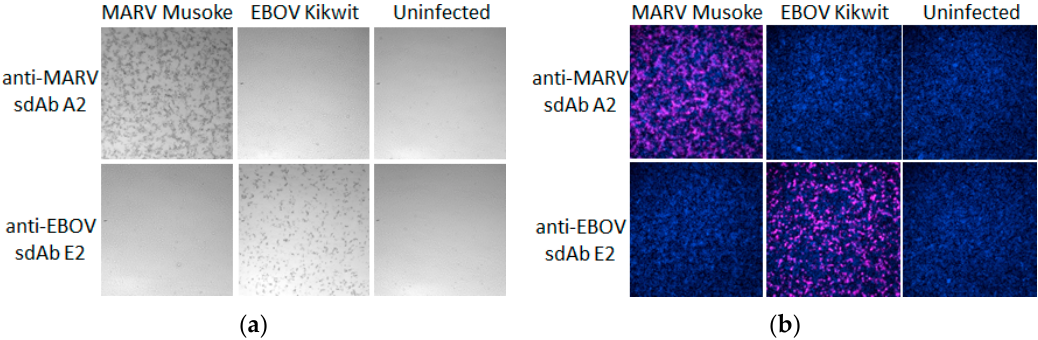
Figure 12. Dimeric sdAb–APEX2 fusions at 10 nM were used to probe Vero cells 24 h post-infection with either MARV Musoke or EBOV Kikwit for development using ( a ) DAB or ( b ) Amplex ® UltraRed. Magnification was at 10×.